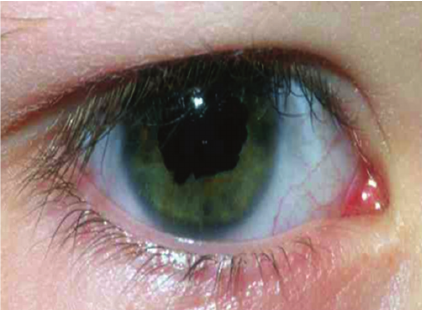
Figure 2: Right eye: exposed glaucoma tube implant in the super- otemporal quadrant due to erosion of the overlying conjunctiva with no visible pericardial patch graft.